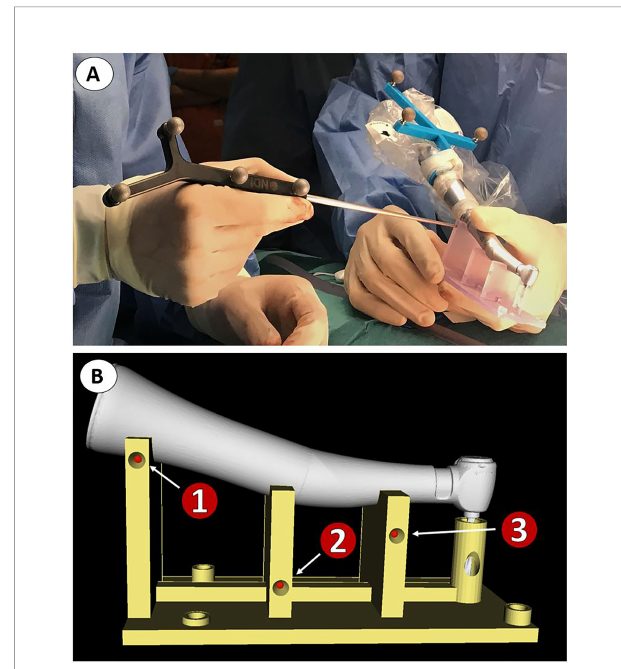
FIGURE 4 | Calibration of handpiece tool prior to dynamic navigation. (A) Surgeons recording reference points in the tool calibration platform. (B) 3D model of the calibration